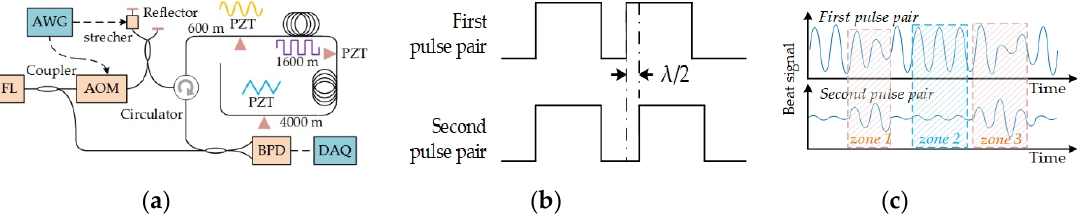
Figure 7. Experimental diagrams. ( a ) System setup of double pulse scheme; ( b ) Pulse pair; ( c ) Beat signal of different pulse pairs. Reproduced from our previous paper [63] and [15].